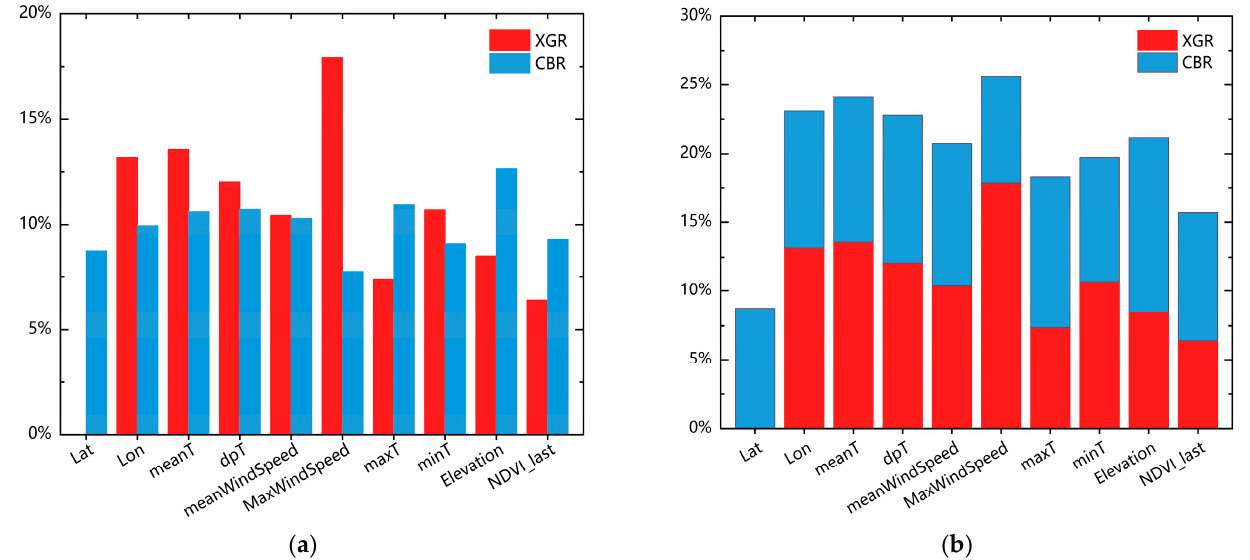
Figure 12. Generated feature weight diagram of XGR and CBR. ( a ) represents the weight values of each feature separately calculated by CBR model and XGR model. ( b ) represents the sum of weight values obtained by XGR and CBR models weighted 1:1; XGR, eXtreme gradient boosting regression, CBR: categorical gradient boosting.